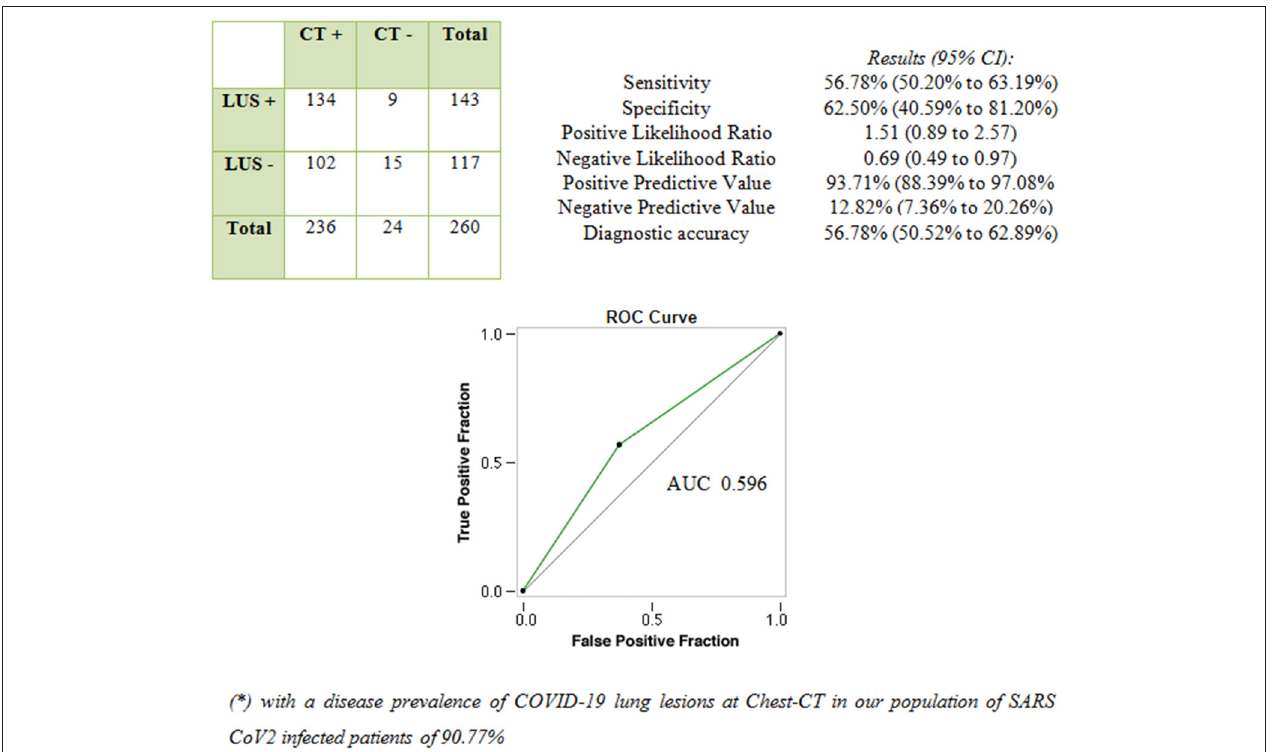
FIGURE 1 | Performance of LUS in diagnosing COVID-19 pneumonia compared with chest CT scan (“gold standard” test).